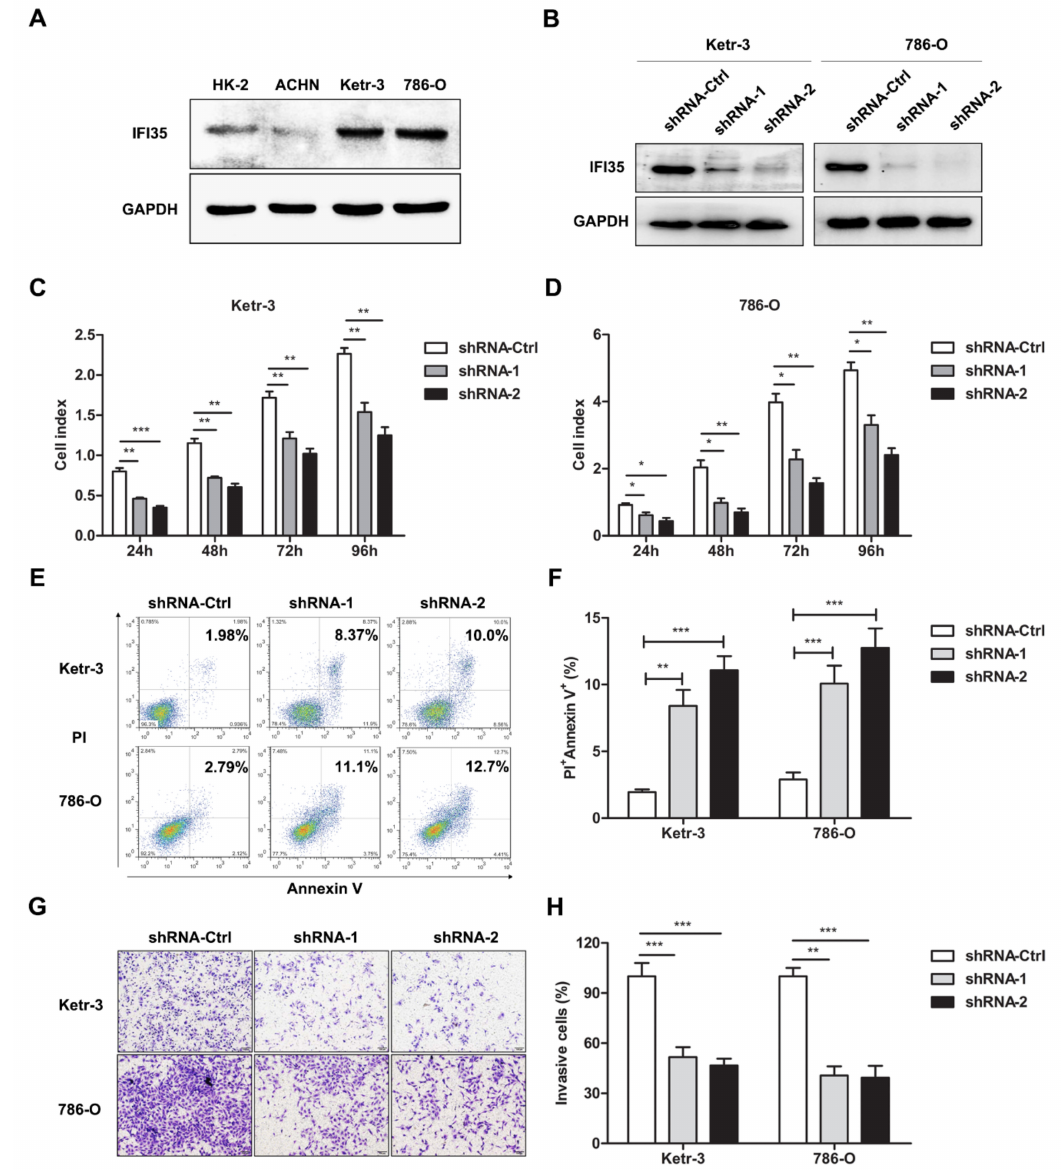
Figure 2. Knockdown of IFI35 inhibited cell proliferation and invasion and promoted cell apoptosis in renal cancer cells. ( A ) IFI35 expression was detected by Western blot in HK-2, ACHN, Ketr-3, and 786-O cell lines. ( B ) Forty-eight hours after IFI35-shRNA transfection, IFI35 expression was evaluated by Western blot in IFI35 shRNA-treated Ketr-3 or 786-O cells. ( C , D ) The proliferation assay conducted by RTCA was performed after shRNA-treated in Ketr-3 and 786-O. ( E ) The cell apoptosis was detected by flow cytometry in shRNA or shRNA-Ctrl-treated Ketr-3 and 786-O. ( F ) The percentages of apoptotic cells are represented in ( E ). ( G , H ) The invasion of Ketr-3 and 786-O cells was detected in the shRNA-treated group or shRNA-Ctrl-treated group. Data are from one representative experiment of three performed and presented as the mean ± SD, cell samples, n ≥ 3. Statistical significance was set at * p < 0.05, ** p < 0.01, and *** p < 0.001. Original blots see Supplementary File